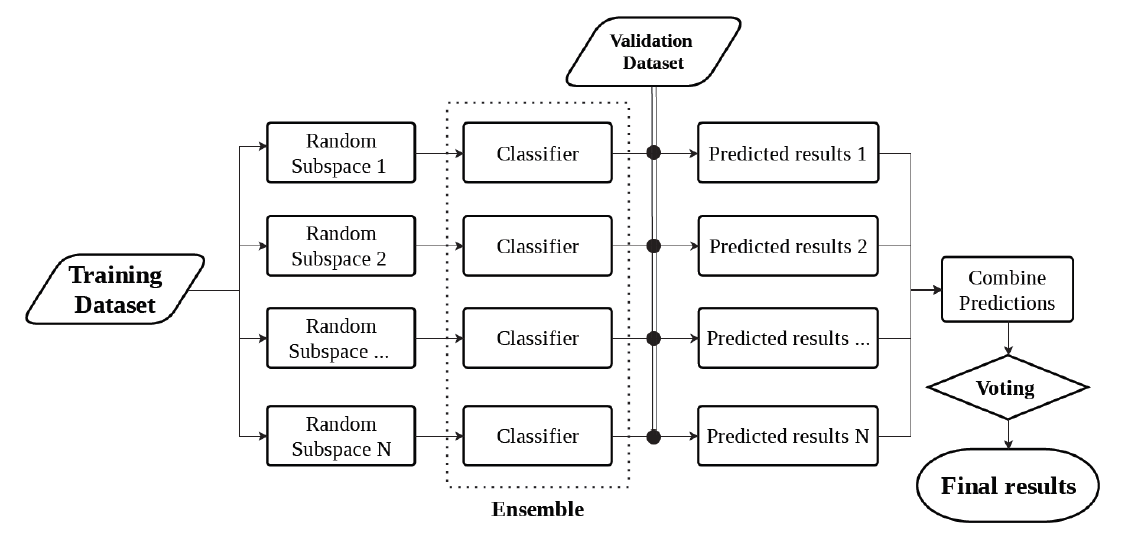
Figure 4. Overview of ensemble machine learning technique using random subspace sampling. Table 5. Dataset arrangement of the glucose acoustic spectrum for ML training purposes.